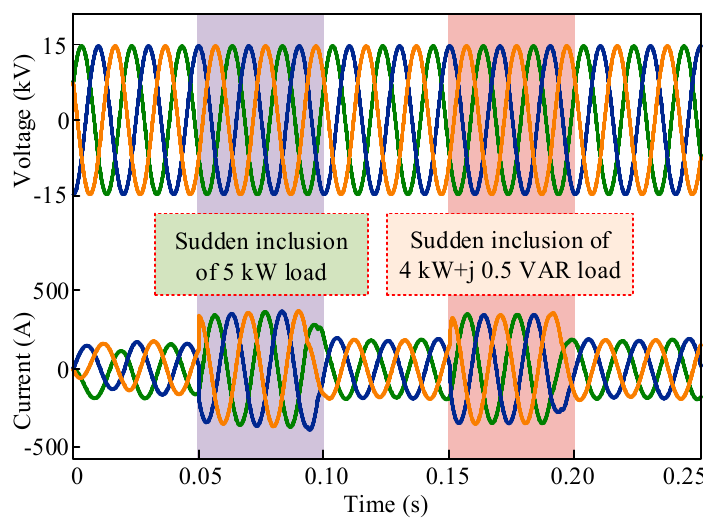
Figure 14. Sudden load change response of the inverter.